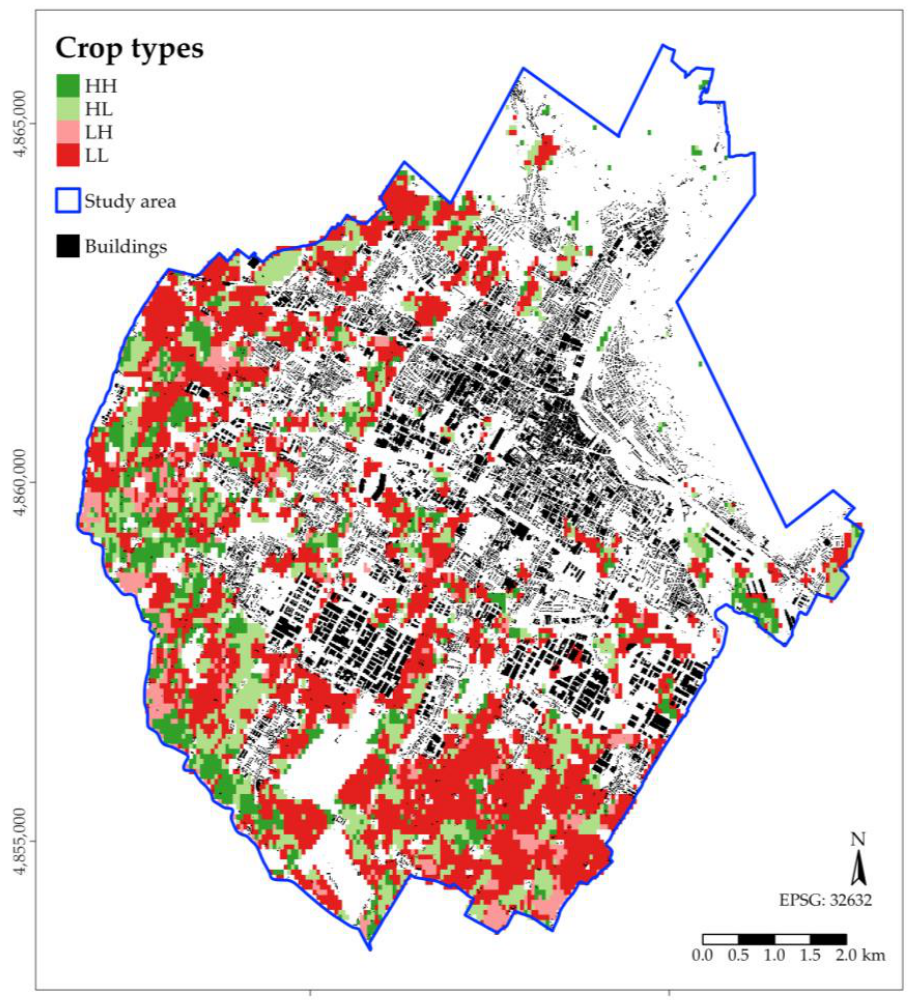
Figure 4. Annual crop areas classification based on NDVI values relative to 22 June and 16 August 2021 (H = NDVI > 0.5; L = NDVI < 0.5).